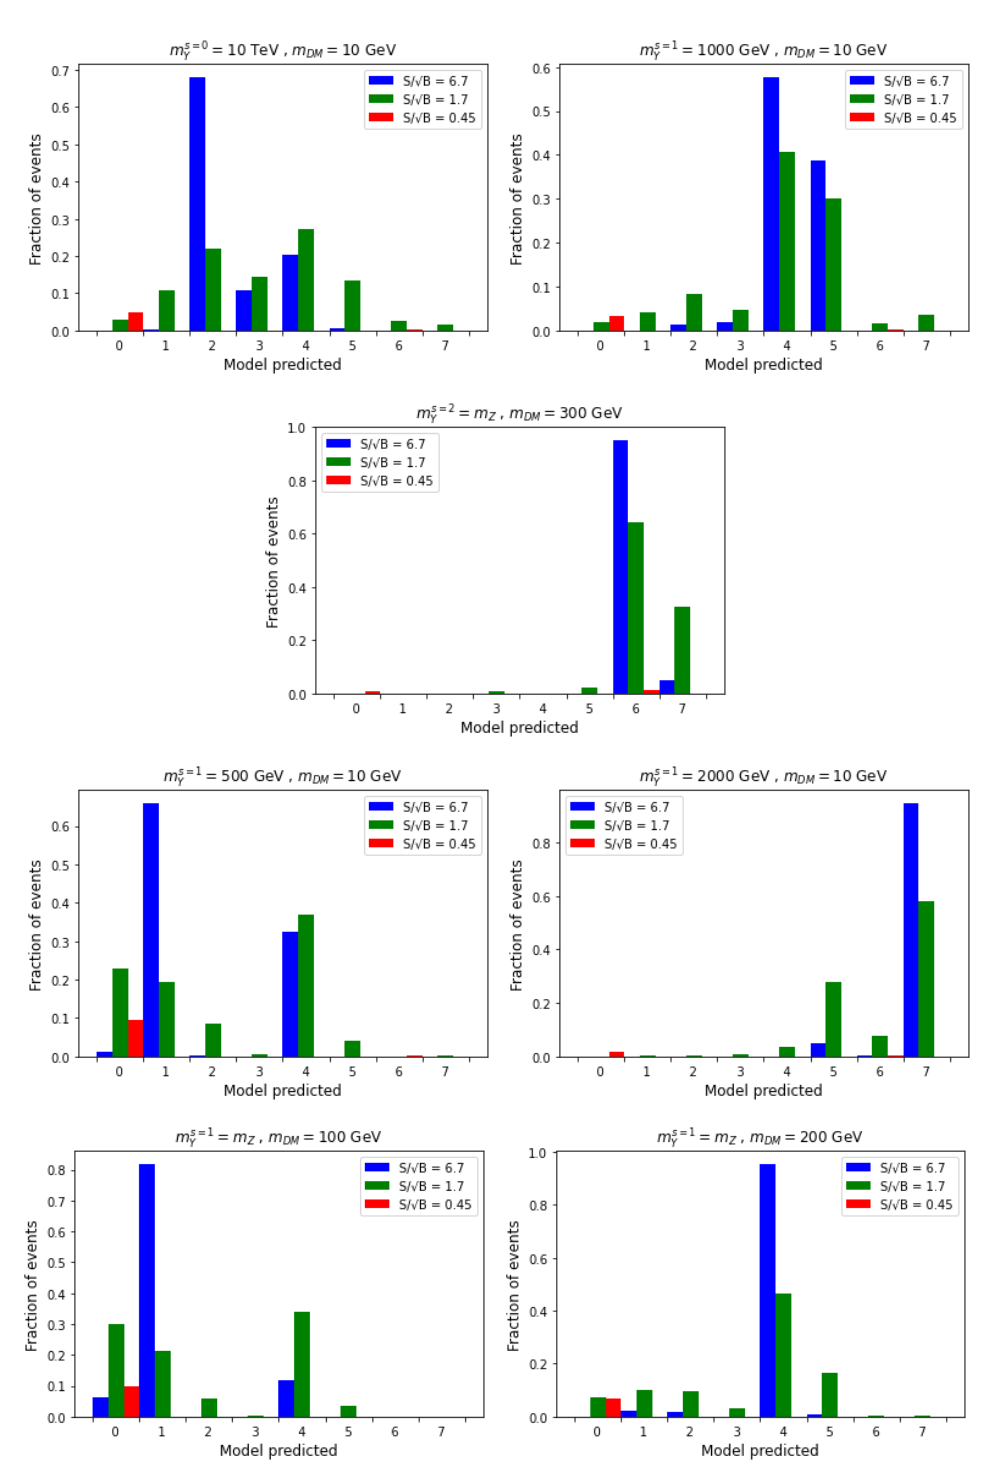
Figure 18: Same as in Fig. 17, but test samples are generated with different models from those the network was